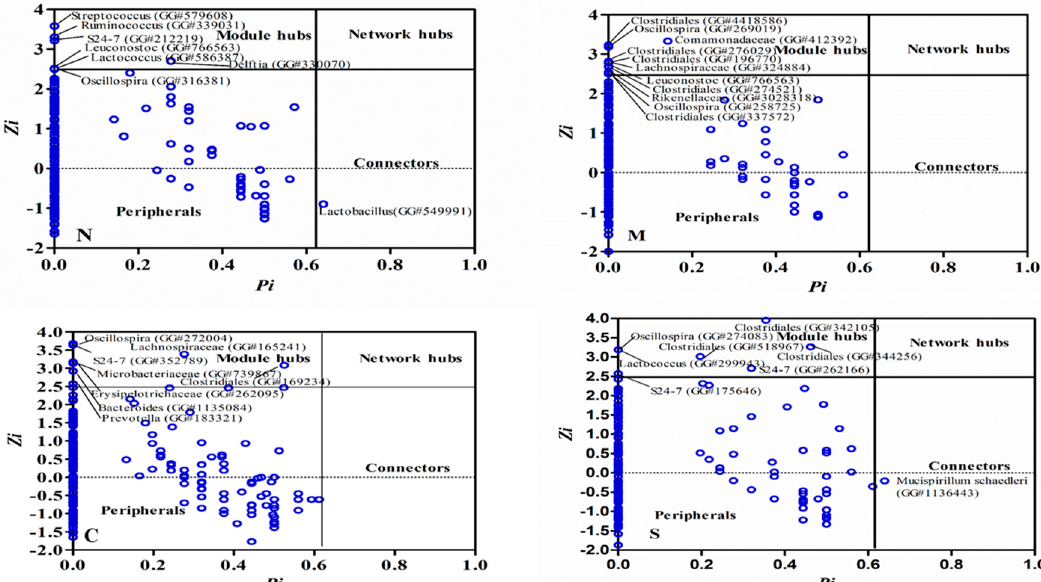
Figure 1. The scatter plot showing the distribution of OTU based on their topological roles in the network. The detailed information for each OTU can be found in Table S3. Each dot represents an OTU. Zi: within-module connectivity. Pi: Among-module connectivity. The network topological role classification was originally proposed by Olesen et al., 2007. N: healthy mice supplemented with phosphate-buffered saline (PBS); C: healthy mice supplemented with a daily dose of 150 mg/kg bodyweight of chondroitin sulfate disaccharide (CSD) for 16 consecutive days; M: mice subjected to exhaustive exercise stress supplemented with PBS; S: the stressed mice supplemented with a daily dose of 150 mg/kg bodyweight of CSD for 16 days.